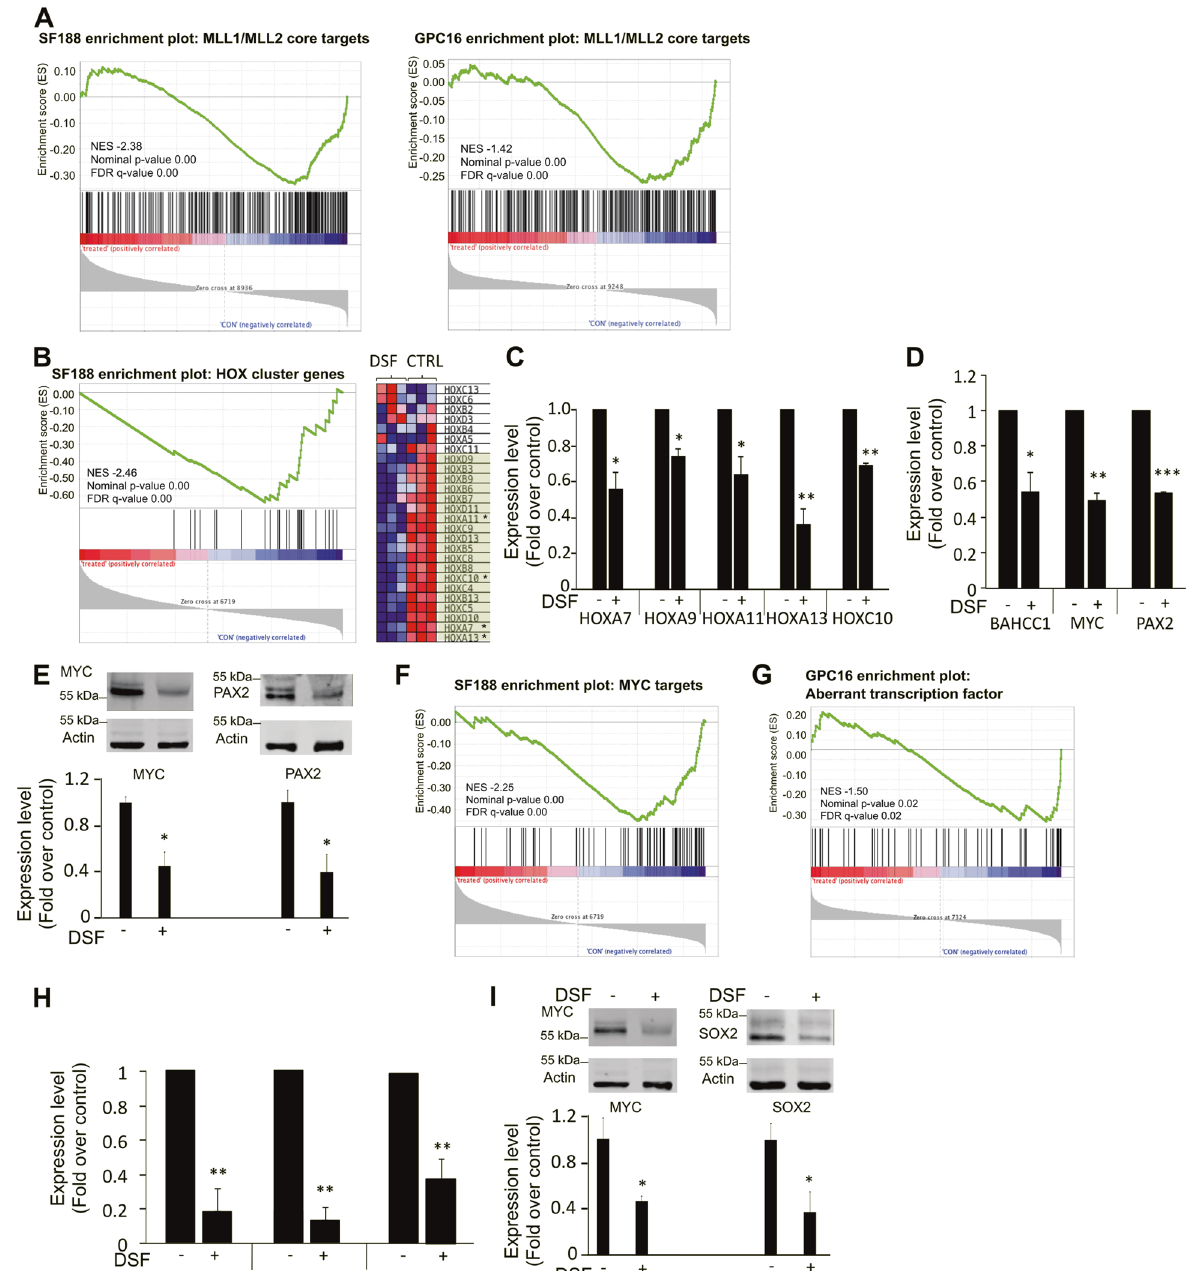
Fig. 6 Changes in SF188 and GPC16 gene expression following disul fi ram treatment. A and B GSEA showing downregulation of MLL1/MLL2 core genes set (genes downregulated upon MLL1/MLL2 downregulation) in disul fi ram-treated SF188 and GPC16 cells. C GSEA showing downregulation of HOX cluster genes set (gene set including all 39 human Hox cluster genes) in disul fi ram-treated SF188 cells. The heatmap is part of the GSEA. It represents Hox cluster genes expression in disul fi ram-treated (DSF) and untreated cells (CTRL) with three replicates each. Genes present in the core enrichment signature are highlighted in green, genes marked with an asterisk were further analyzed. C qPCR analyses of HOX genes expression in disul fi ram-treated SF188 cells. Data are mean ± STD; n = 3; ∗ p < 0.05, ∗∗ p < 0.01; one-sample t -test. D qPCR analyses of transcription factors expression upon disul fi ram treatment. Data are mean ± STD; n = 3; ∗ p < 0.05, ∗∗ p < 0.01, ∗∗∗ p < 0.001; one- sample t -test. E Western blot analysis of MYC and PAX2 expression level upon disul fi ram treatment. Data are mean ± STD; n = 3; ∗ p < 0.05, t - test. F GSEA showing downregulation of MYC targets genes set (genes upregulated upon MYC expression) in disul fi ram-treated SF188 cells (MSigDB gene set: SCHUHMACHER_MYC_TARGETS_UP). G GSEA showing downregulation of aberrant transcription factor set (75 transcription factors with aberrant expression in glioblastoma as reported by Rheinbay et al.) in disul fi ram-treated GPC16 cells. H qPCR analyses of OLIG2 , SOX2 , and MYC expression in disul fi ram-treated GPC16 cells. Data are mean ± STD; n = 3; ∗∗ p < 0.01; one-sample t -test. I Western blot analysis of SOX2 and MYC expression level upon disul fi ram treatment. Data are mean ± STD; n = 3; ∗ p < 0.05, t -test.